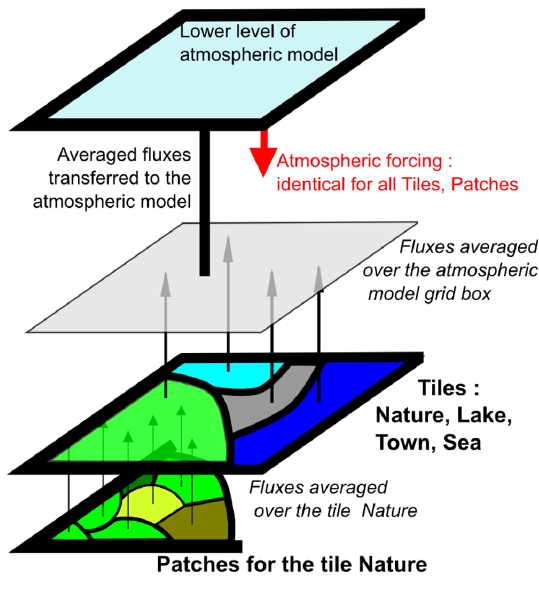
Fig. 3. Schematic representation of the organisation of the surface using four main tiles and patches for nature (soil and vegetation